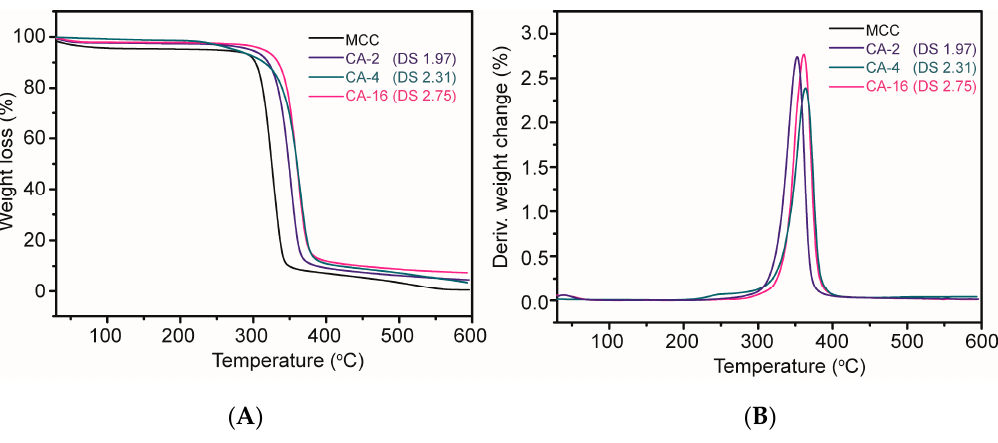
Figure 3. TGA ( A ) and DTG ( B ) spectra of MCC and modified samples.